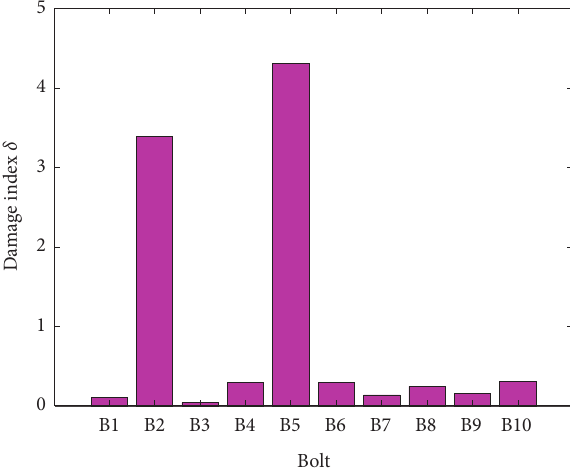
Figure 11: Histogram of bolt looseness damage